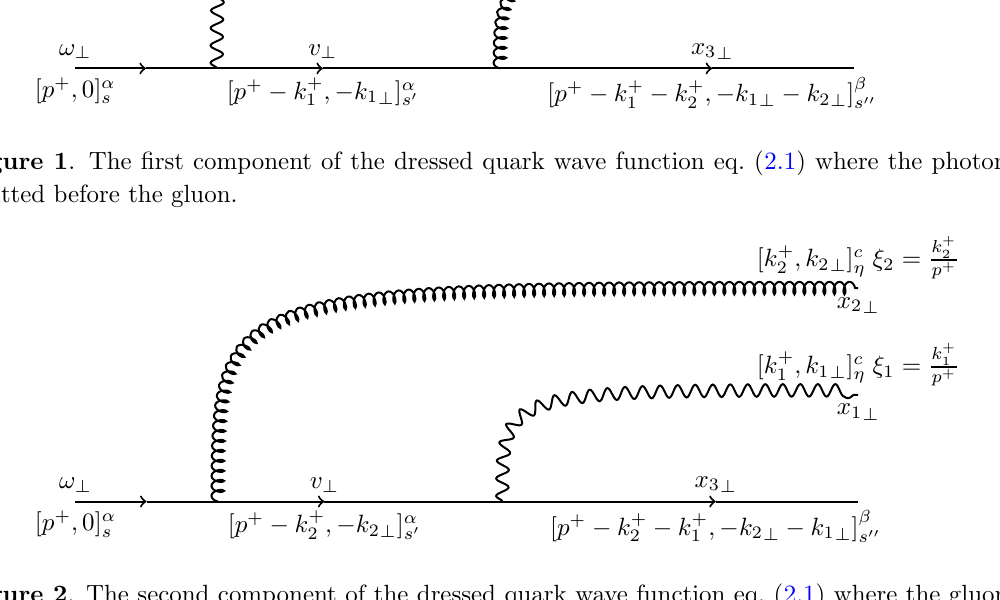
Figure 2 . The second component of the dressed quark wave function eq. (2.1) where the gluon is emitted before the